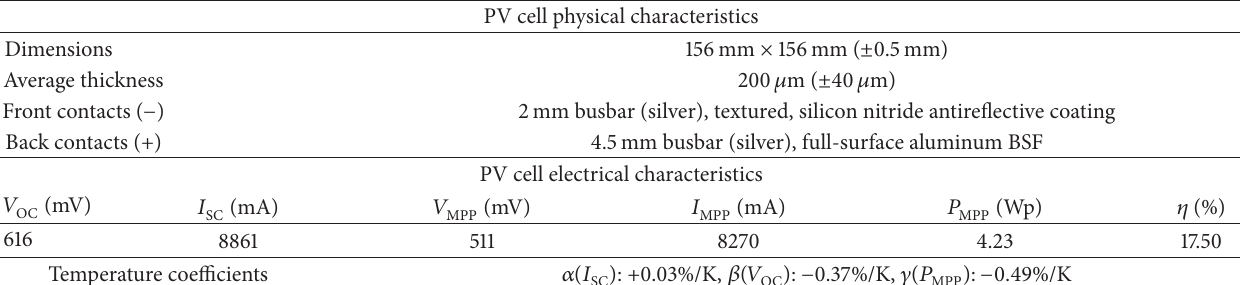
Table 1: Physical and electrical properties of the Bosch M 2BB PV cell [11]. Electrical data applies for standard test conditions (1000W/m 2 , AM 1.5, and 25 ∘